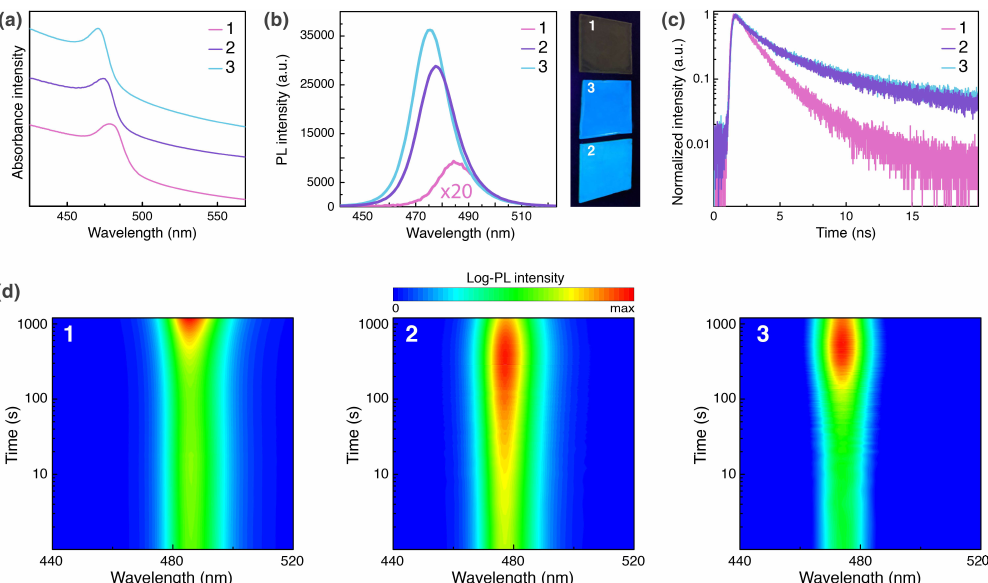
Figure 2. ( a ) Absorption spectra of the films 1 – 3 . ( b ) Photoluminescence spectra of the samples. The intensity of the PL peak for 1 is multiplied by 20 times. A side image: photograph of the films under evenly distributed 360 nm UV lamp illumination ( P = 0.1 W · cm − 2 ). ( c ) Time-resolved PL decay curves for 1 – 3 . ( d ) Temporal behavior of PL for the films upon severe UV excitation ( P = 5 W · cm − 2